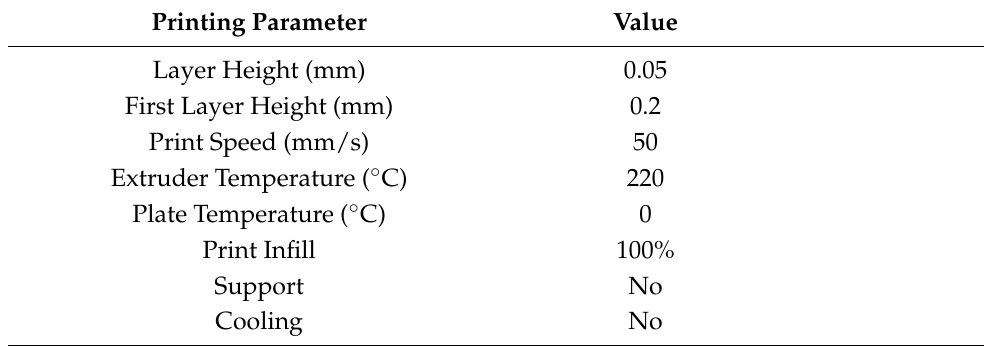
Table 1. Tabulation of printing